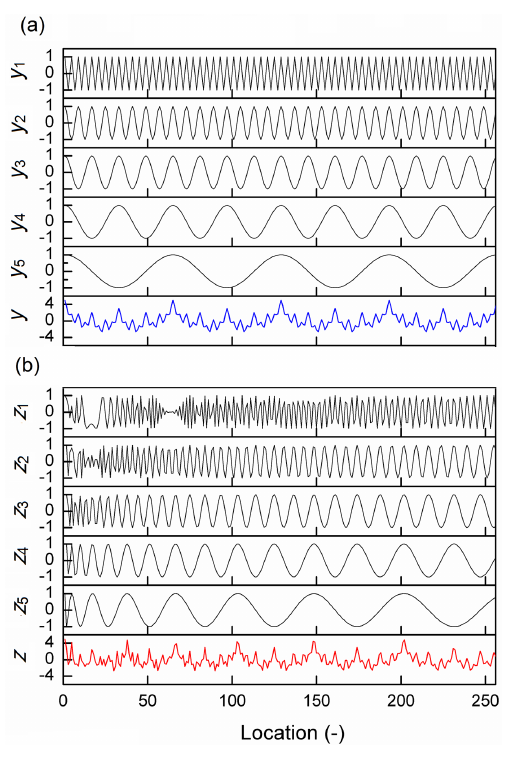
Figure 1. (a) Stationary and (b) non-stationary series of response variables ( y for stationary and z for non-stationary case) encom- passing five cosine waves ( y 1 to y 5 for stationary and z 1 to z 5 for non-stationary case) with different dimensionless